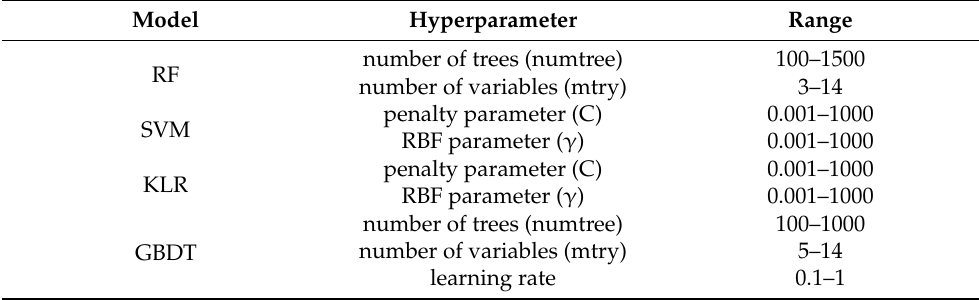
Table 2. Hyperparameter types and the range of nonparametric